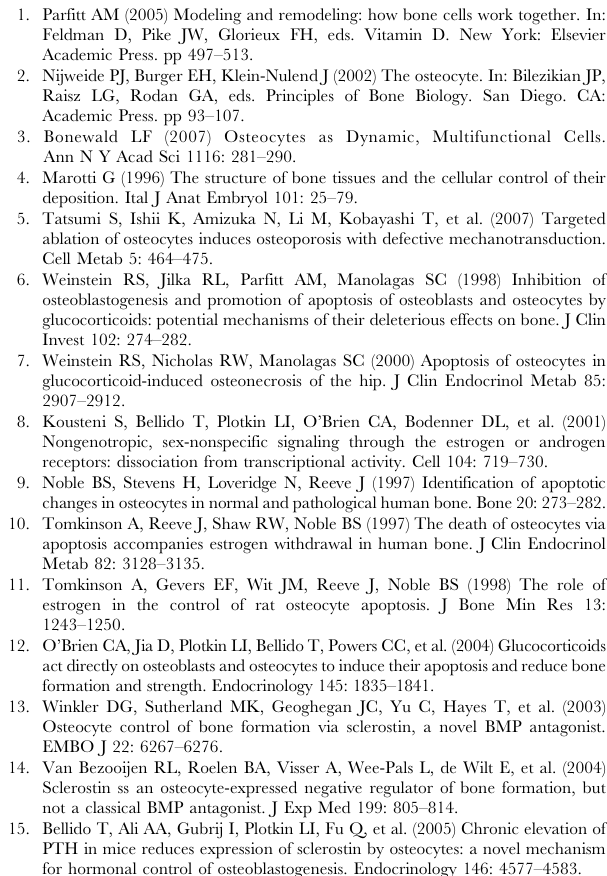
(E) Total, femoral, and spinal BMD in 9-week-old WT and DMP1- Figure S2 Micro-CT Analysis of 3-Day-Old and 3.5-Week-Old DMP1-caPTHR1 Transgenic Mice (A) Representative longitudinal and cross-sectional micro-CT images of femurs from 3-day-old DMP1-caPTHR1 mice (TG) and wild type littermates (WT). Three animals per genotype were analyzed. The total bone volume per femur was measured. * indicates p , 0.05 vs wild type littermates. (B) Longitudinal and cross-sectional micro-CT images of femurs, 5th lumbar vertebra, and calvaria from 3.5-week-old WT and TG mice. Found at: doi:10.1371/journal.pone.0002942.s002 (0.35 MB TIF) Figure S3 Hematoxylin & Eosin Staining of Longitudinal Sections of Femoral Diaphysis of 4-, 8-, and 12-Week-Old DMP1-caPTHR1 Transgenic Mice Decalcified, paraffin embed- ded femurs were longitudinally sectioned and stained with hematoxylin and eosin. Bars indicate 0.1 mm. Figure S4 Circulating levels of Calcium, Phosphate and PTH are not altered in DMP1-caPTHR1 transgenic mice Plasma levels of (A) total calcium, (B) inorganic phosphate, and (C) PTH in DMP1-caPTHR1 mice and wild type littermates. Bars are mean 6 S.D. (A) n= 4 wild type and 5 transgenic 3.5-week-old; (B) n = 11 wild type and 16 transgenic 2.5-month-old mice; and (C) n =5 wild type and 7 transgenic 2-month-old mice.